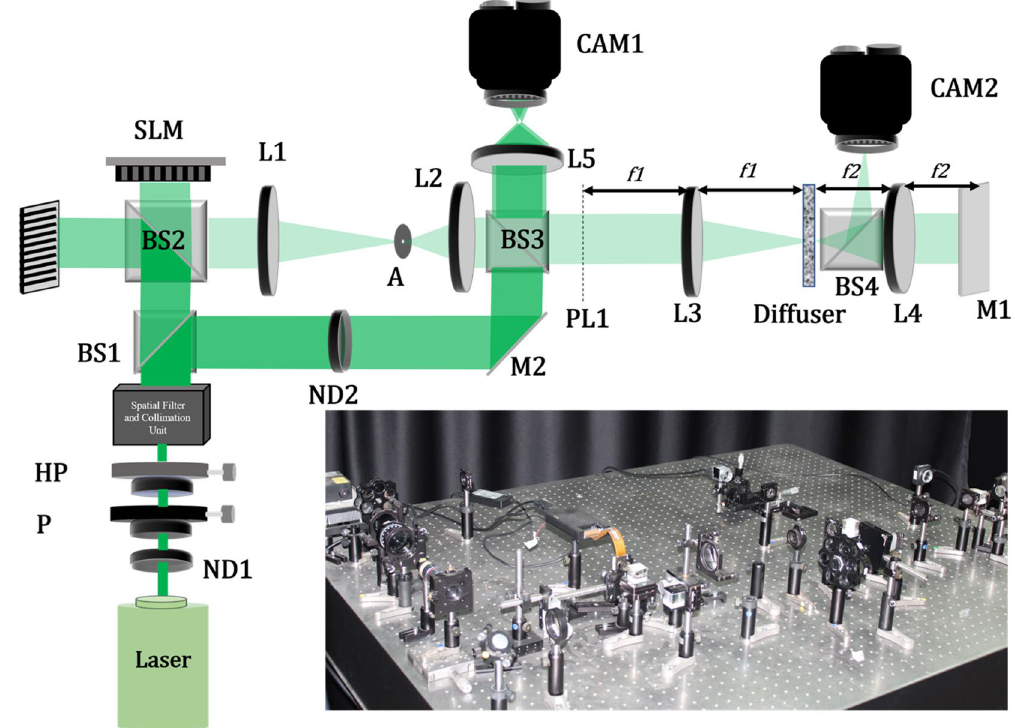
Figure 5. Schematic of the Experimental Setup. (Actual Pic of the Setup in the